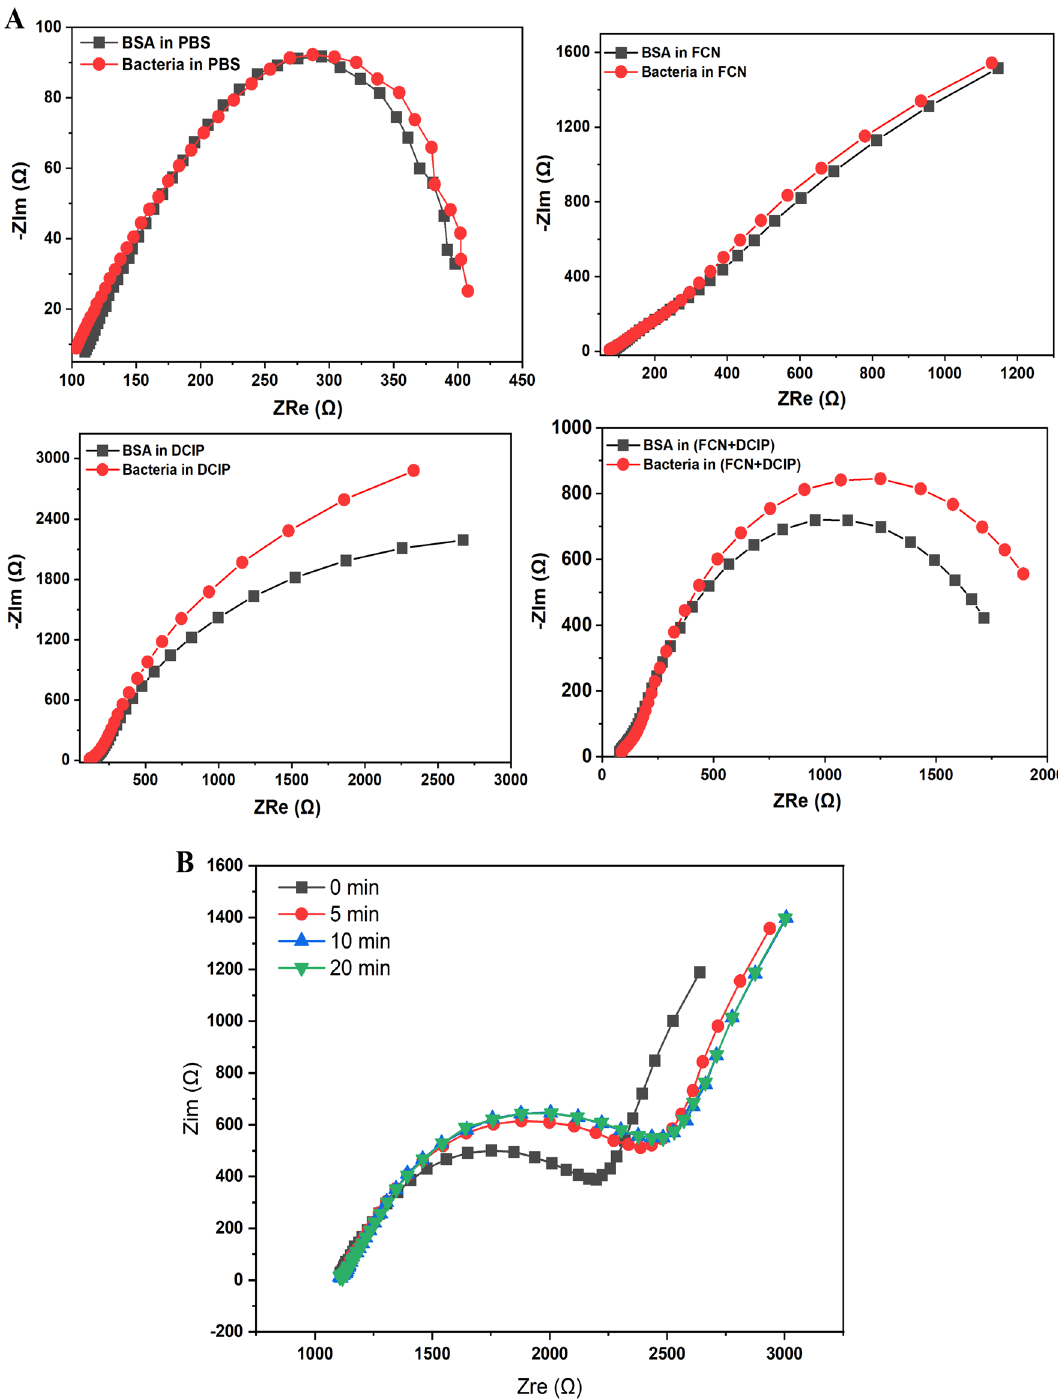
Figure 3. ( A ) EIS Nyquist showing the capturing efficiency of the phage sensors towards the selected pathogen strain. EIS was carried out in different measuring conditions including the sole electrolyte (PBS), FCN, DCIP or a combination of DCIP and FCN. The impedimetric signals were recorded before and after taking place the binding between the immobilized phage and the targeting host cells. ( B ) Effect sensing time on the EIS signal generated by the phage-based biosensor. Bacterial concentration of 1 × 103 CFU/ml was